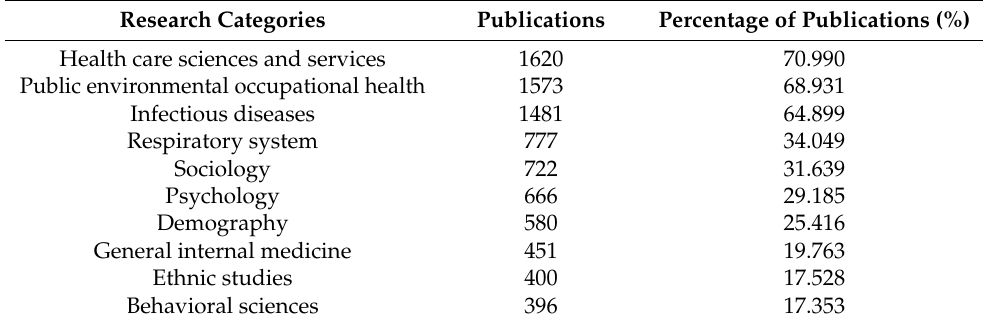
Table 1. Top 10 research categories for health disparity and